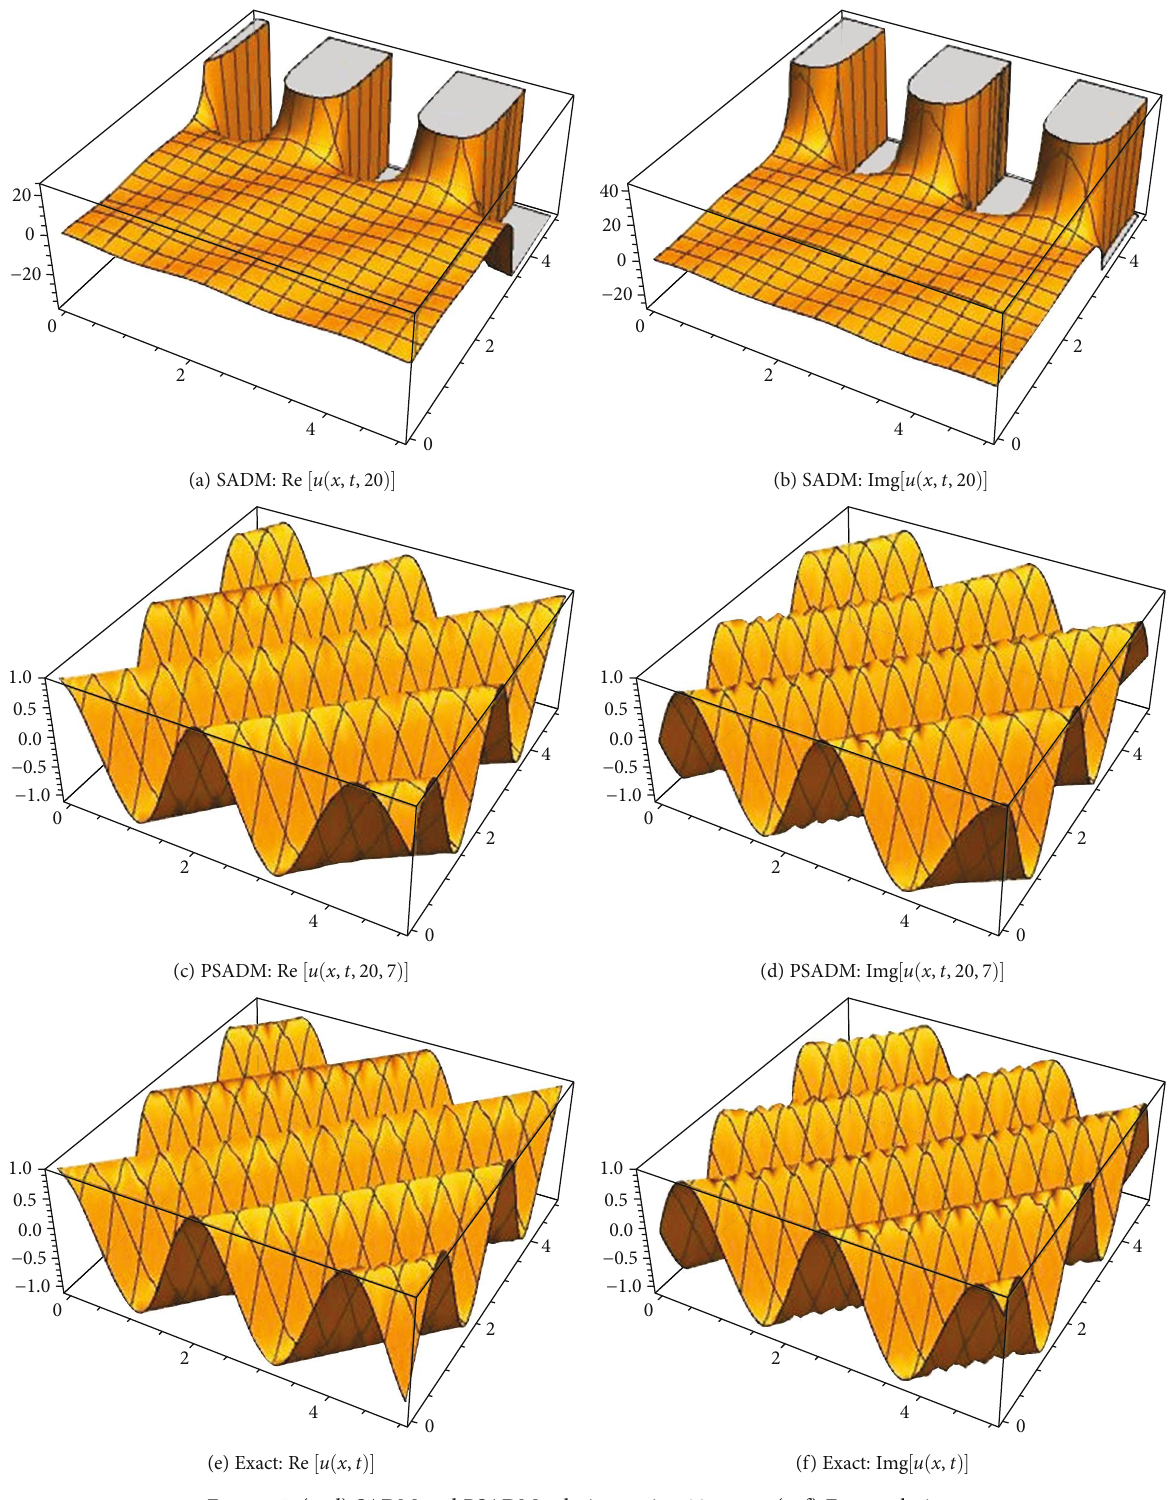
Figure 5: (a – d) SADM and PSADM solutions using 20 terms. (e, f) Exact